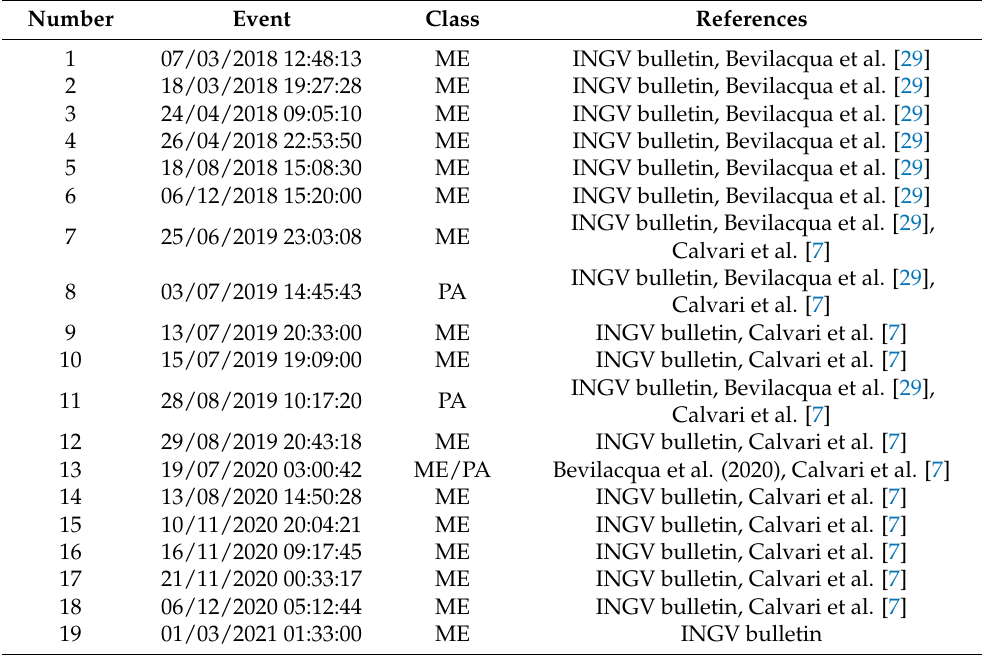
Table 1. List of the powerful eruptive events from January 2018 to April 2021 with the classes derived from Calvari et al. [7], Bevilacqua et al. [29] and the INGV weekly bulletins. Major Explosion (ME), Paroxysm (PA), Not Available (NA) in the case no information is provided. Date and time in dd/mm/yyyy hh:mm:ss format. Time is expressed in UTC.